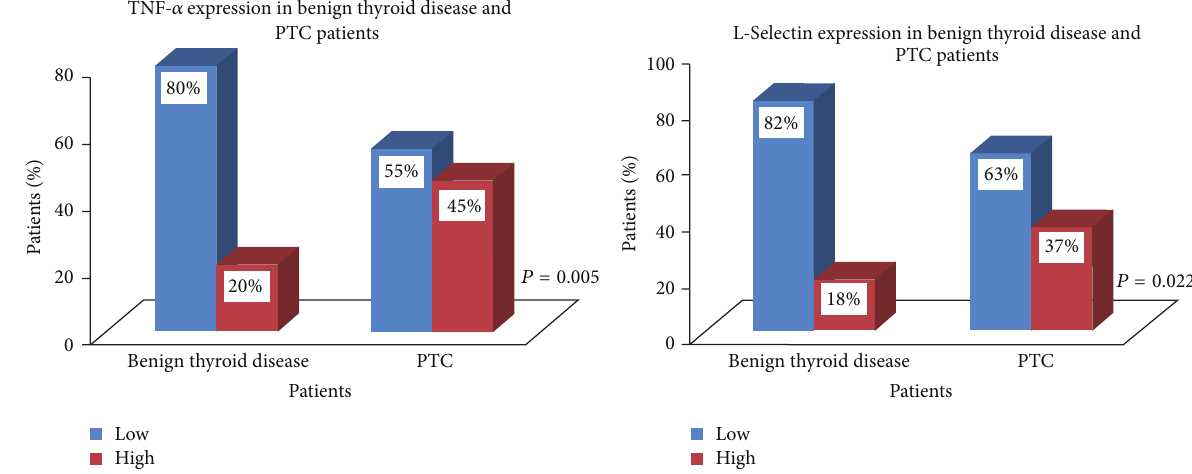
Figure 5: Expression of TNF- 𝛼 and L-Selectin in patients with benign thyroid disease and